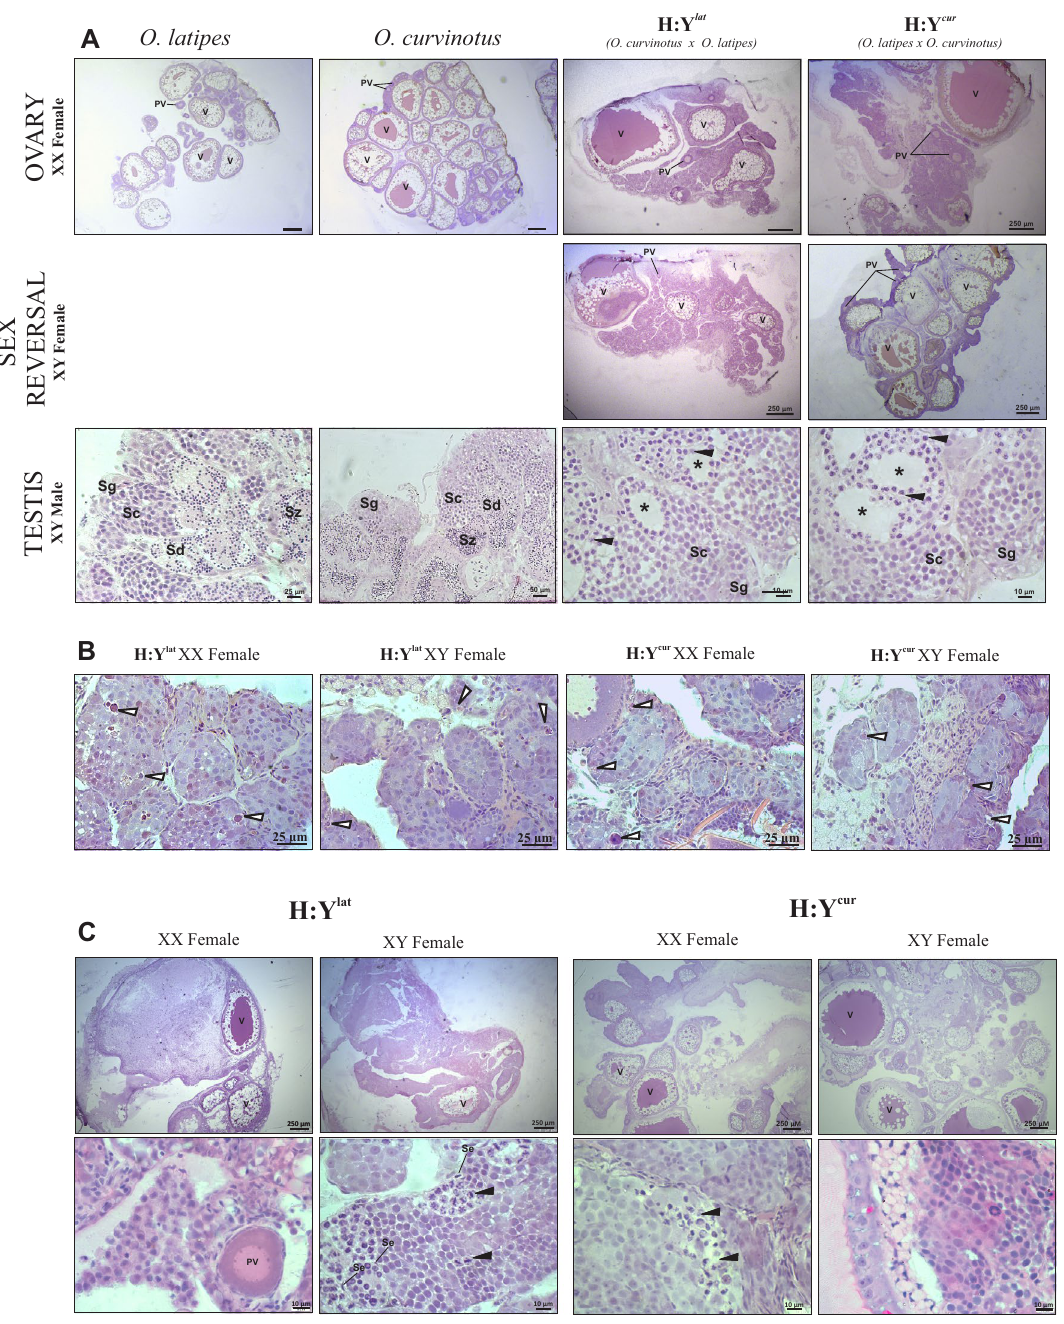
Figure 1. Morphology analysis of adult gonad of parental O. latipes , O. curvinotus and hybrids. ( A ) Wild type parental fish and hybrids (H:Y lat and H:Y cur ) male and female (XX and XY). In the parental ovaries, more vitellogenic oocytes are present in comparison to the hybrids. Hybrid testis present empty seminiferous tubules (star). ( B ) Higher magnification of H:Y lat XX female and H:Y cur XY male. Ovaries of hybrids show increased numbers of germ cell clusters. ( C ) Gonad histology of H:Y lat XX female and XY female with 2.5 years old fish. V vitellogenic oocytes, PV pre-vitellogenic oocytes, Se sertoli cells, Sg spermatogonia, Sc spermatocyte, Sd spermatid, Sz spermatozoa, Black arrow spermatocyte arrested in meiosis, * empty seminiferous tube, White arrow cells in